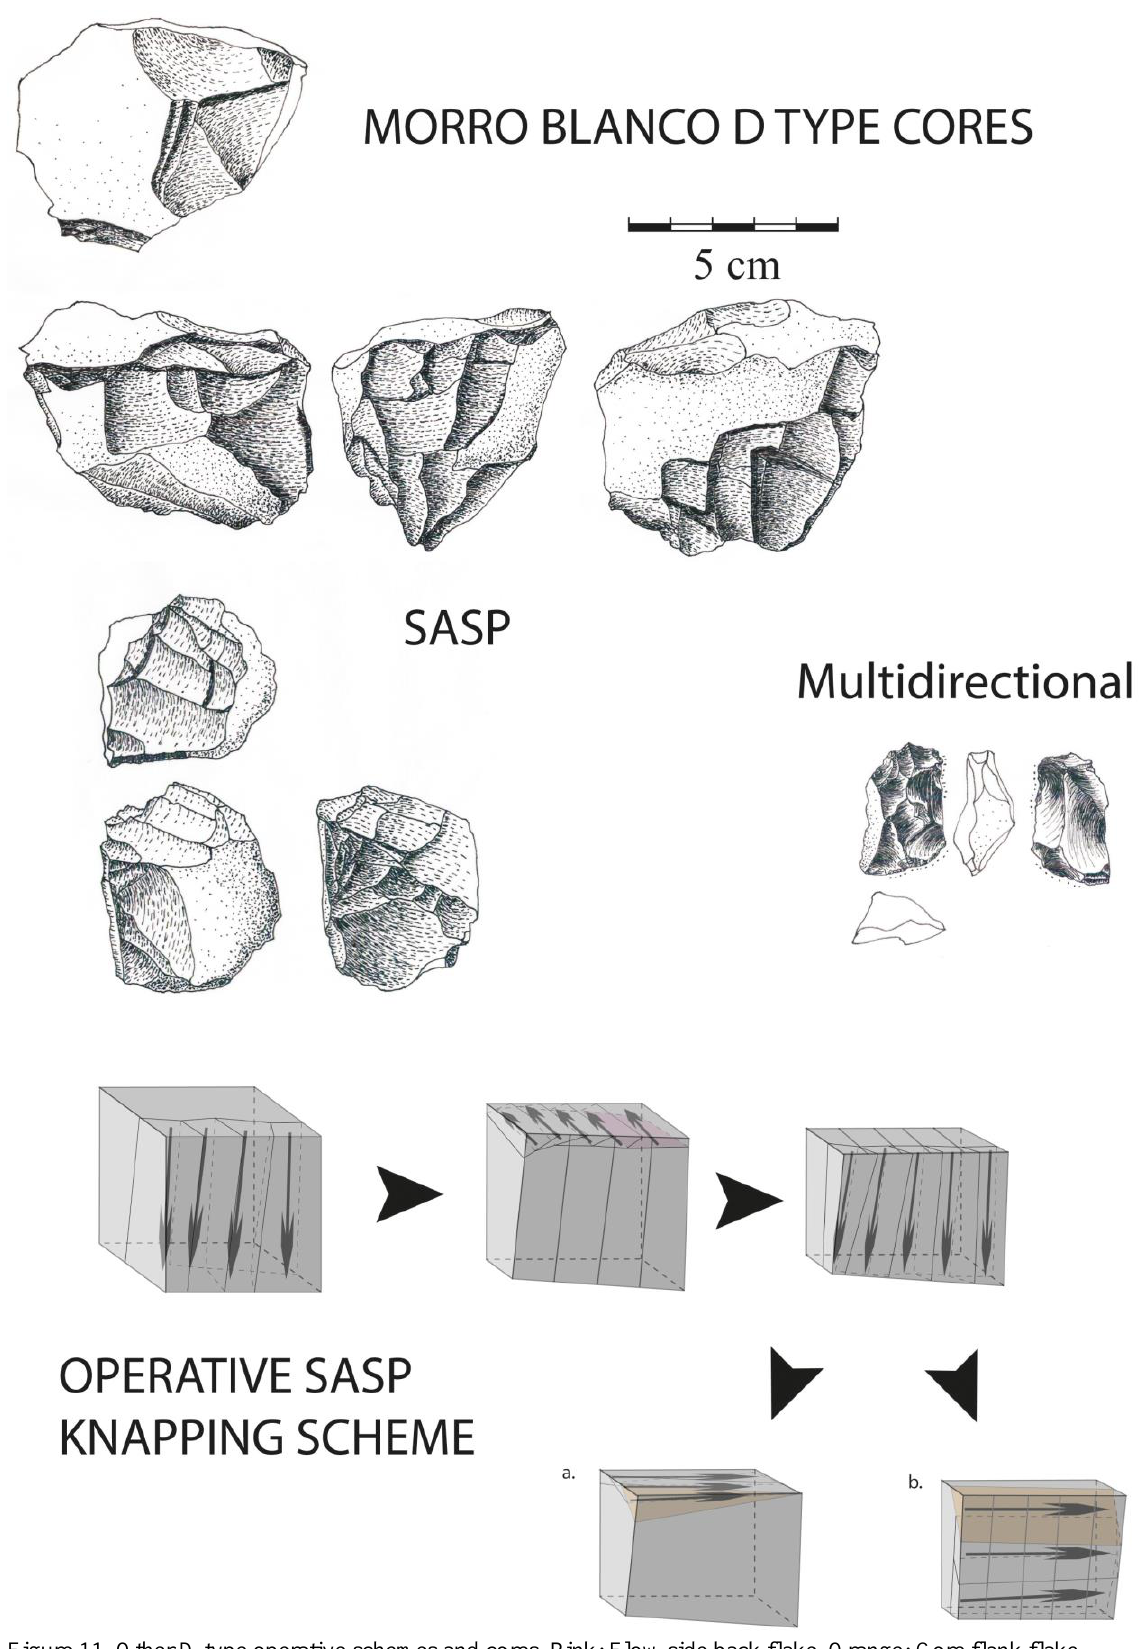
Figure 11. Other D type operative schemes and cores. Pink: Flow side back flake. Orange: Core flank